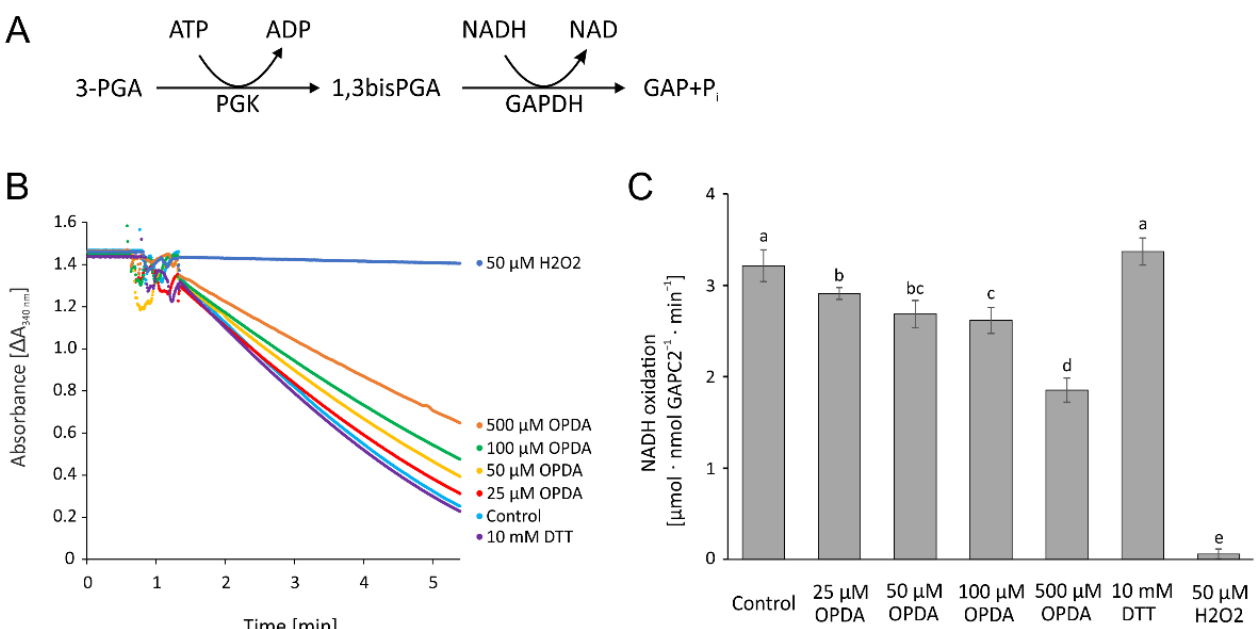
Figure 11. OPDA effect on cytosolic glyceraldehyde-3-phosphate dehydrogenase C2 activity. ( A ) Reaction scheme. ( B ) Representative absorbance recordings normalized to the identical time point of GAPC2 addition and similar baselines after the addition of 15 nM GAPC2. In total, 1 µM reduced